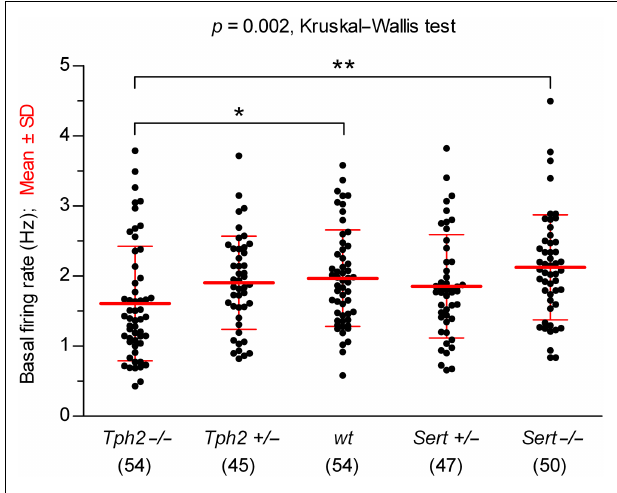
FIGURE 1 | Comparison of 5-HT neuron basal firing rates across genotypes. Data are shown as mean ± SD (number of cells shown in parentheses). Analysis of data using Kruskal–Wallis test revealed statistically significant differences among groups [ H ( 4 ) = 16.67, p = 0.002]. Dunn’s multiple comparison post hoc test resulted in being significant for Sert − / − vs. Tph2 − / − (** p < 0.01) and wt vs. Tph2 − / − (* p <